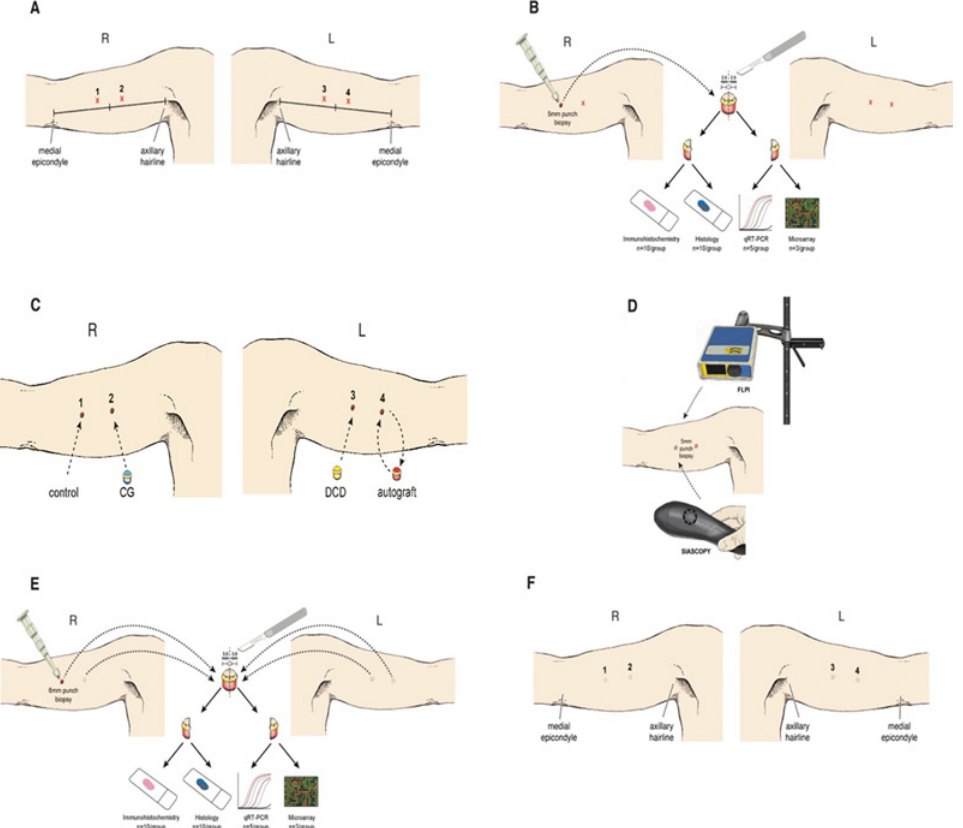
Figure 1. Cohort study methodology. On day 0, 2 sites on each upper arm were allocated (A). Sites were scanned using full-field laser perfusion imaging (FLPI) and spectrophotometric intracutaneous analysis (SIAscopy), before 5mm punch biopsies were taken under local anaesthetic (B). Excised tissue was processed using a range of laboratory techniques. Site 1 was left to heal by secondary intention, site 2 was filled with a 5mm disc of collagen-GAG scaffold (CG), site 3 treated with a 5mm disc of human decellularised dermis (DCD) while excised tissue from site 4 was replaced in the defect acting as an autograft (C). Subjects were seen weekly for 6 weeks where the wound was assessed clinically and non-invasive scanning repeated (D). Subjects subsequently underwent 6mm excision punch biopsies of healing tissue based on study group allocation (E). Excised tissue was again processed using a range of laboratory techniques. All wounds in the study healed satisfactorily leaving a small scar